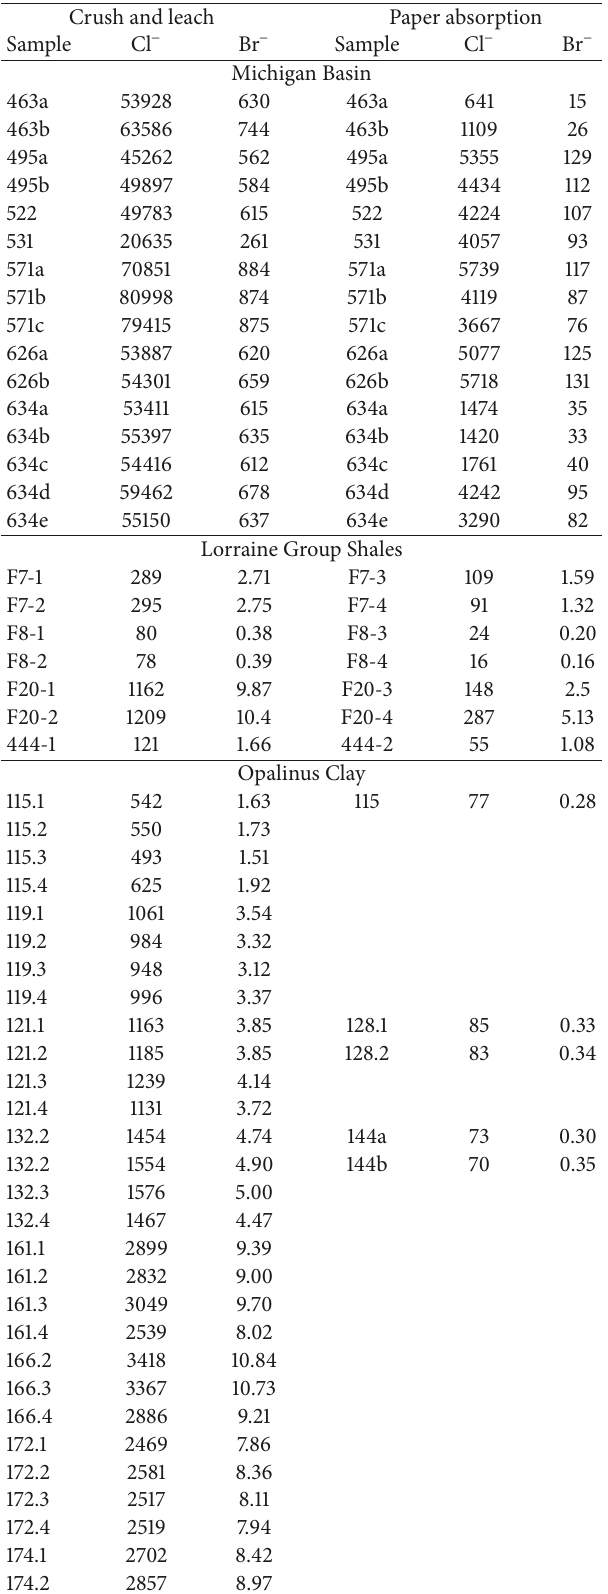
Table 2: Masses ( 𝜇 g) of Cl − and Br − extracted by the crush-and- leach and paper-absorption methods. Crush and